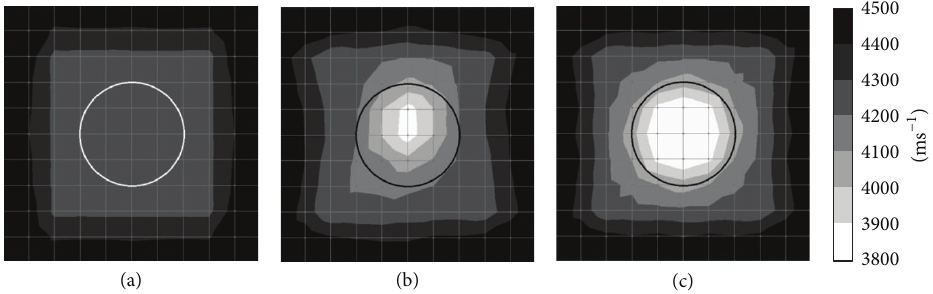
velocity lower than 3900 ms −1 on the location of 50% void although it seems to be smaller than it is supposed to